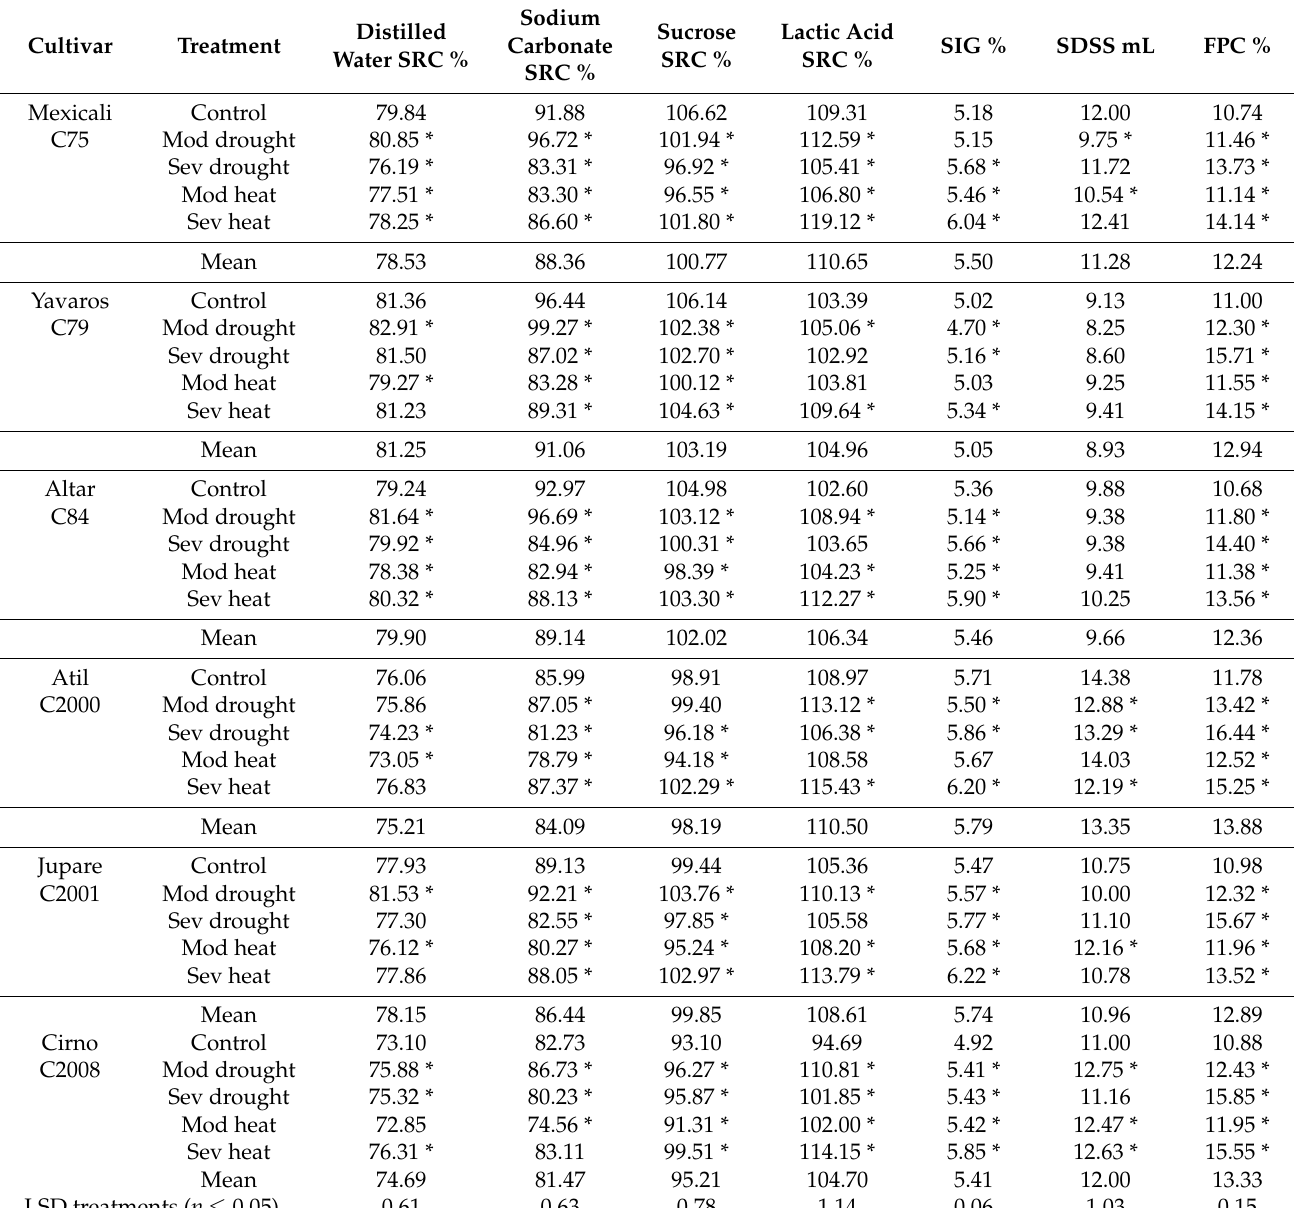
Table 1. Solvent retention capacity, swelling index of glutenin, SDS sedimentation and flour protein content for six cultivars averaged for two